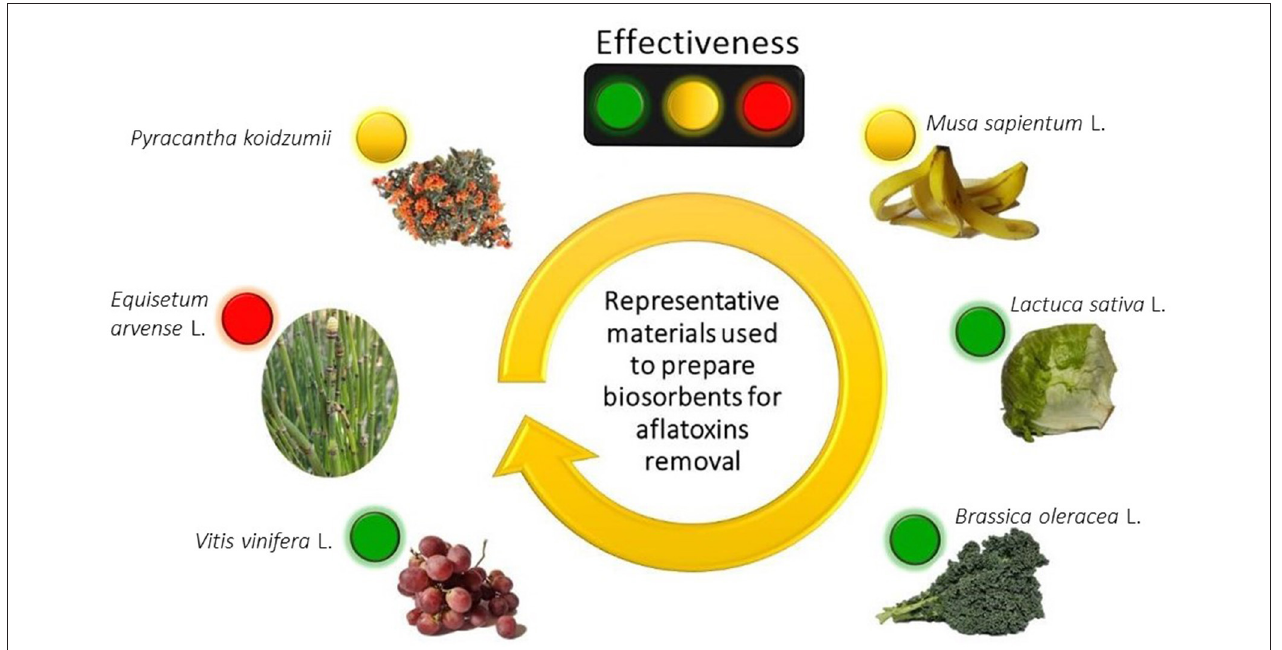
FIGURE 4 | The effectiveness of some biosorbents to remove aflatoxins. Adsorption efficiency: red (low), yellow (moderate) and green (high). Created with BioRender.com.